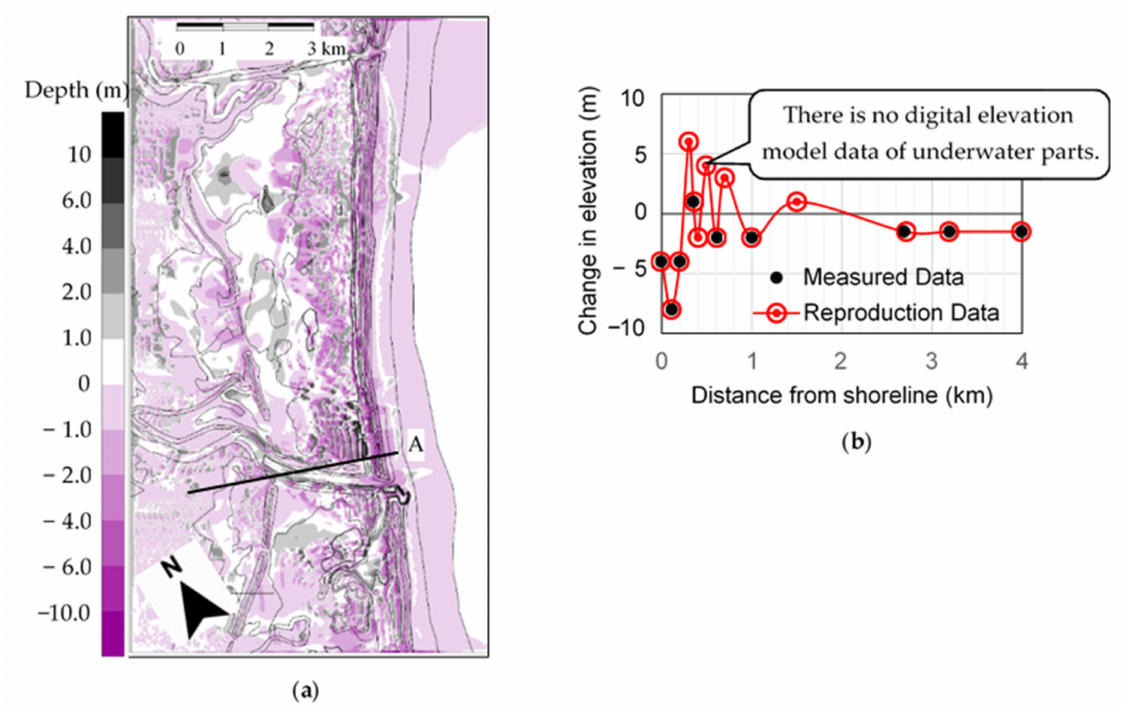
Figure 9. ( a ) Topography change results (Total bed—load), 48 min from start of the tsunami calculations [19]. ( b ) Rel- ative accuracy of the topography-change along line (A)—shown on Figure 9. ( a )—on the measured and reproduced simulation results